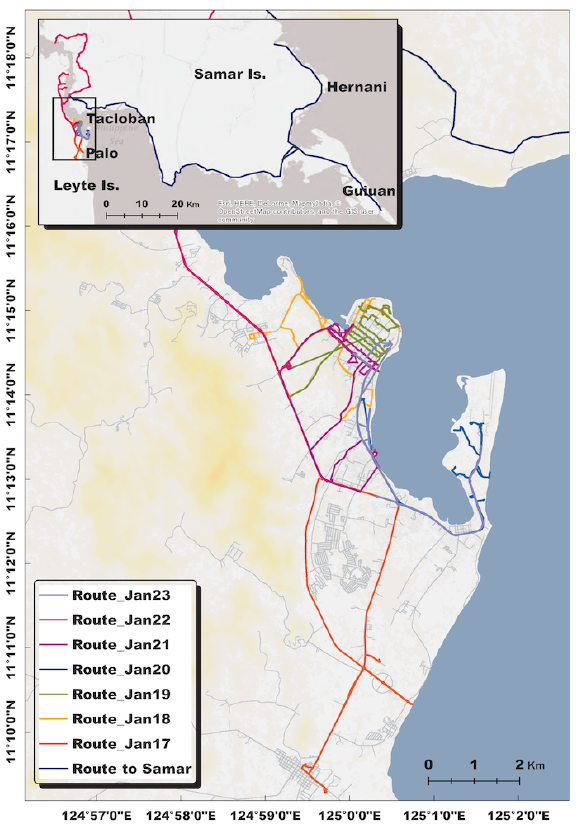
Figure 6. The colored lines show the daily survey routes of the team. Areas surveyed: Palo, Candahug (McArthur Park), Tacloban airport, Magallanes, downtown Tacloban (green route), Anibong, Northern Leyte, Western and Eastern Samar, Guiuan and Hernani.